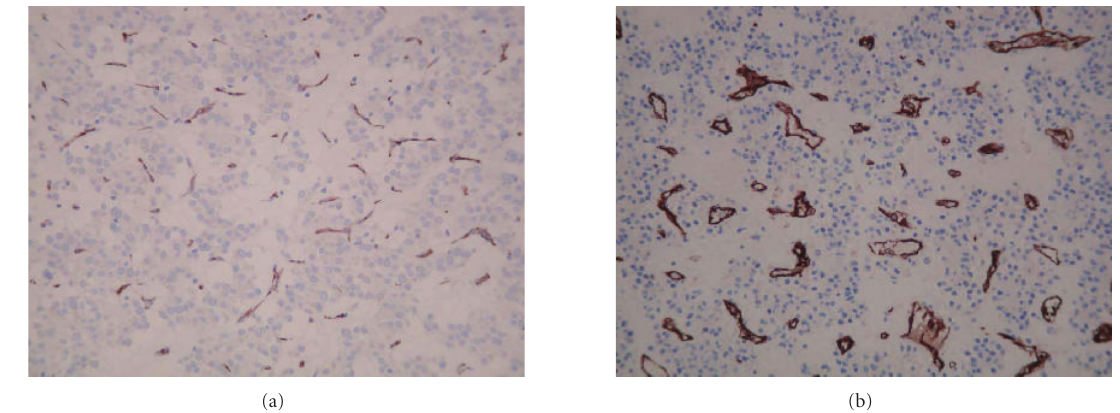
Figure 5: (a) Photomicrograph of representative area of tumour at resection and (b) at post mortem stained with CD31, an endothelial